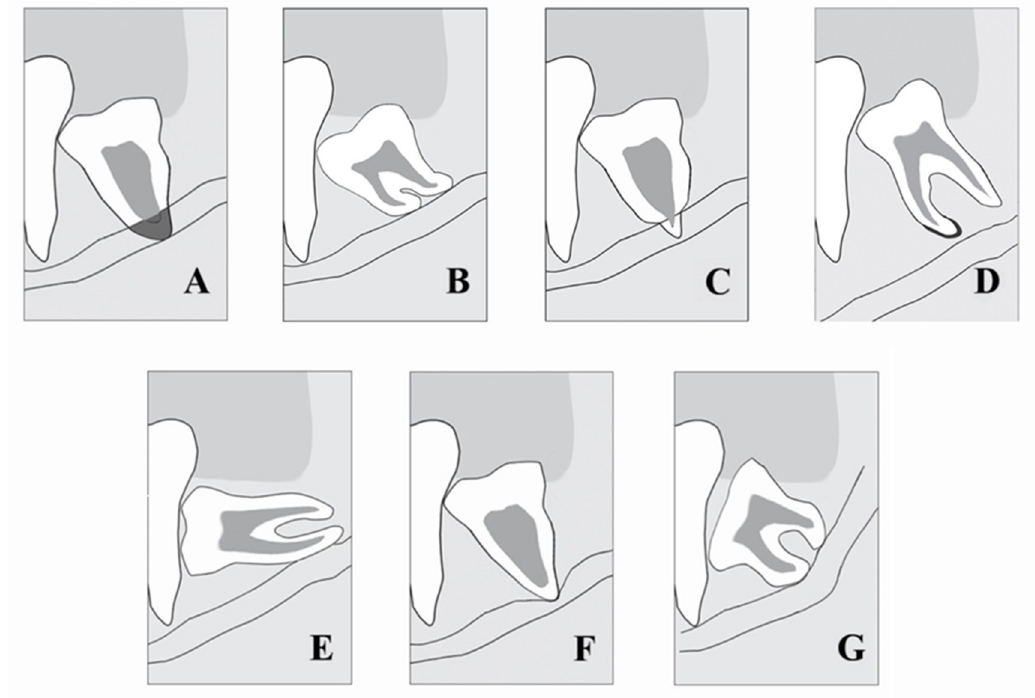
Figure 3. Rood and Shehab classification of radiographic signs: ( A ) root darkening, ( B ) root deflection, ( C ) root narrowing,